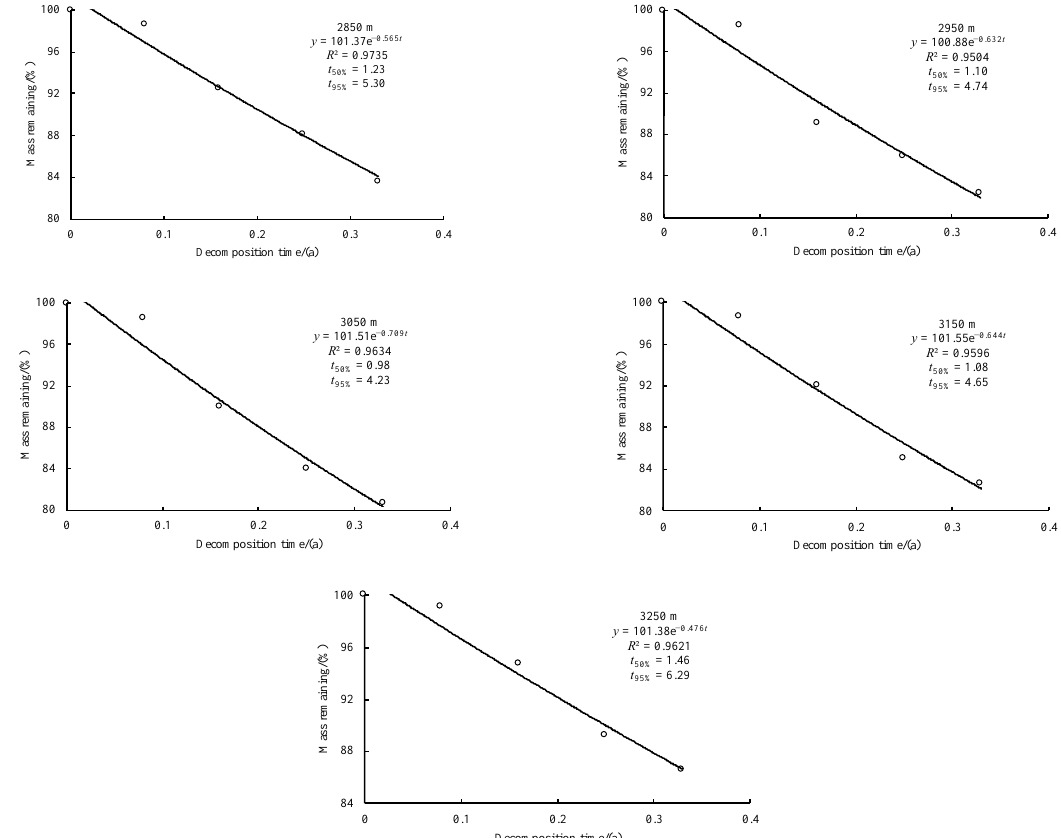
Figure 6. Decomposition model of Qinghai spruce leaf litter at different altitudes in the growing